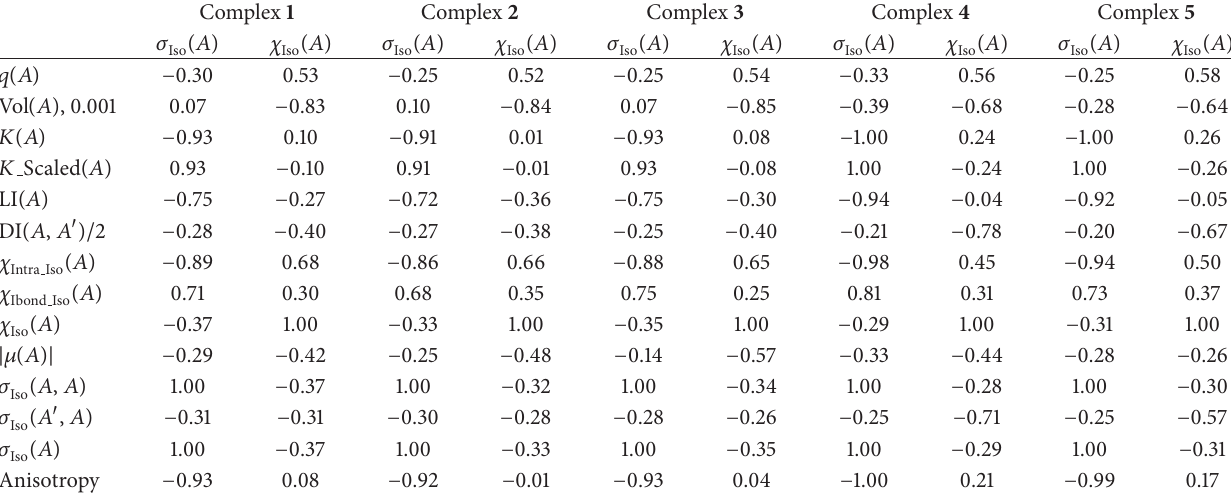
Table 4: The correlation of the computed atomic NMR properties of the